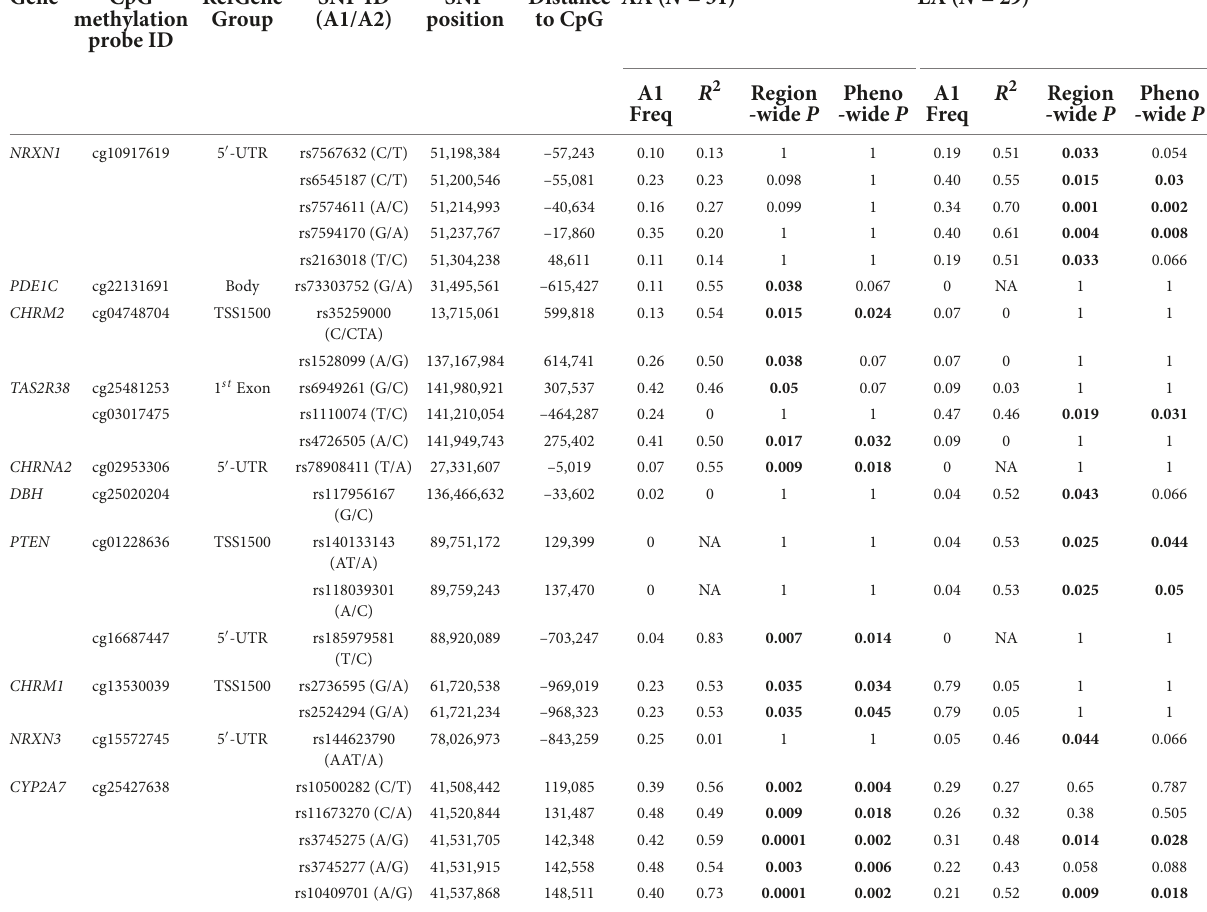
TABLE 2 Significant CpG-SNP pairs with region- or phenotype (pheno)-wide cis associations in the AA and EA samples. Gene CpG methylation probe